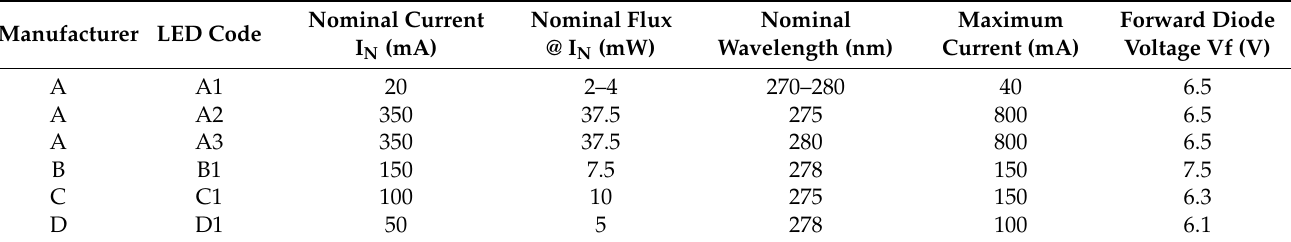
Table 1. LED selection and